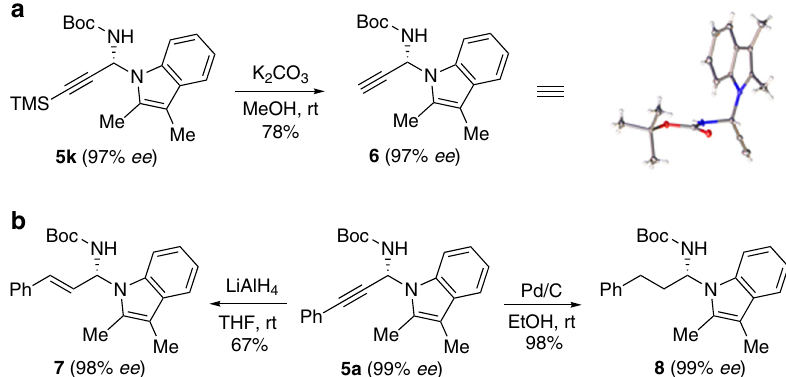
Fig. 7 Product con fi guration determination and transformations. a Product con fi guration determination by X-ray diffraction analysis. b Reduction of the alkynyl group into the alkenyl and alkyl groups.